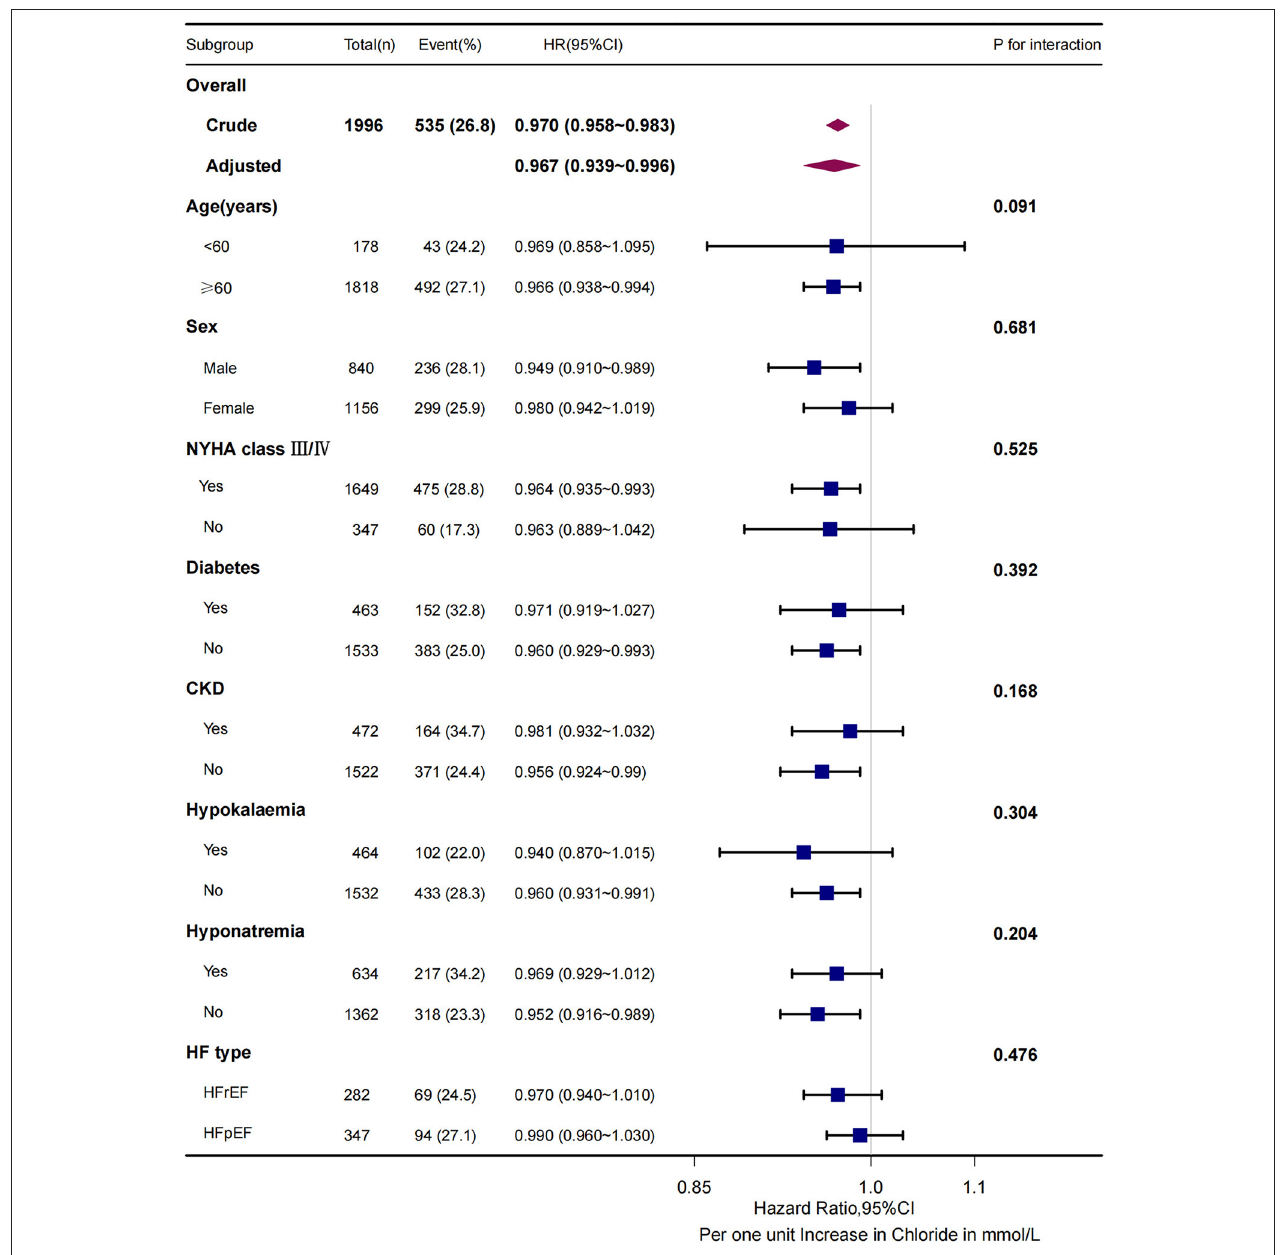
FIGURE 4 | 3-months composite endpoint risk across subgroups. For all subgroups, the P for interaction > 0.05. CKD indicates chronic kidney disease; HFrEF, heart failure with reduced ejection fraction (LVEF < 50%); HFpEF, heart failure with preserved ejection fraction (LVEF ≥